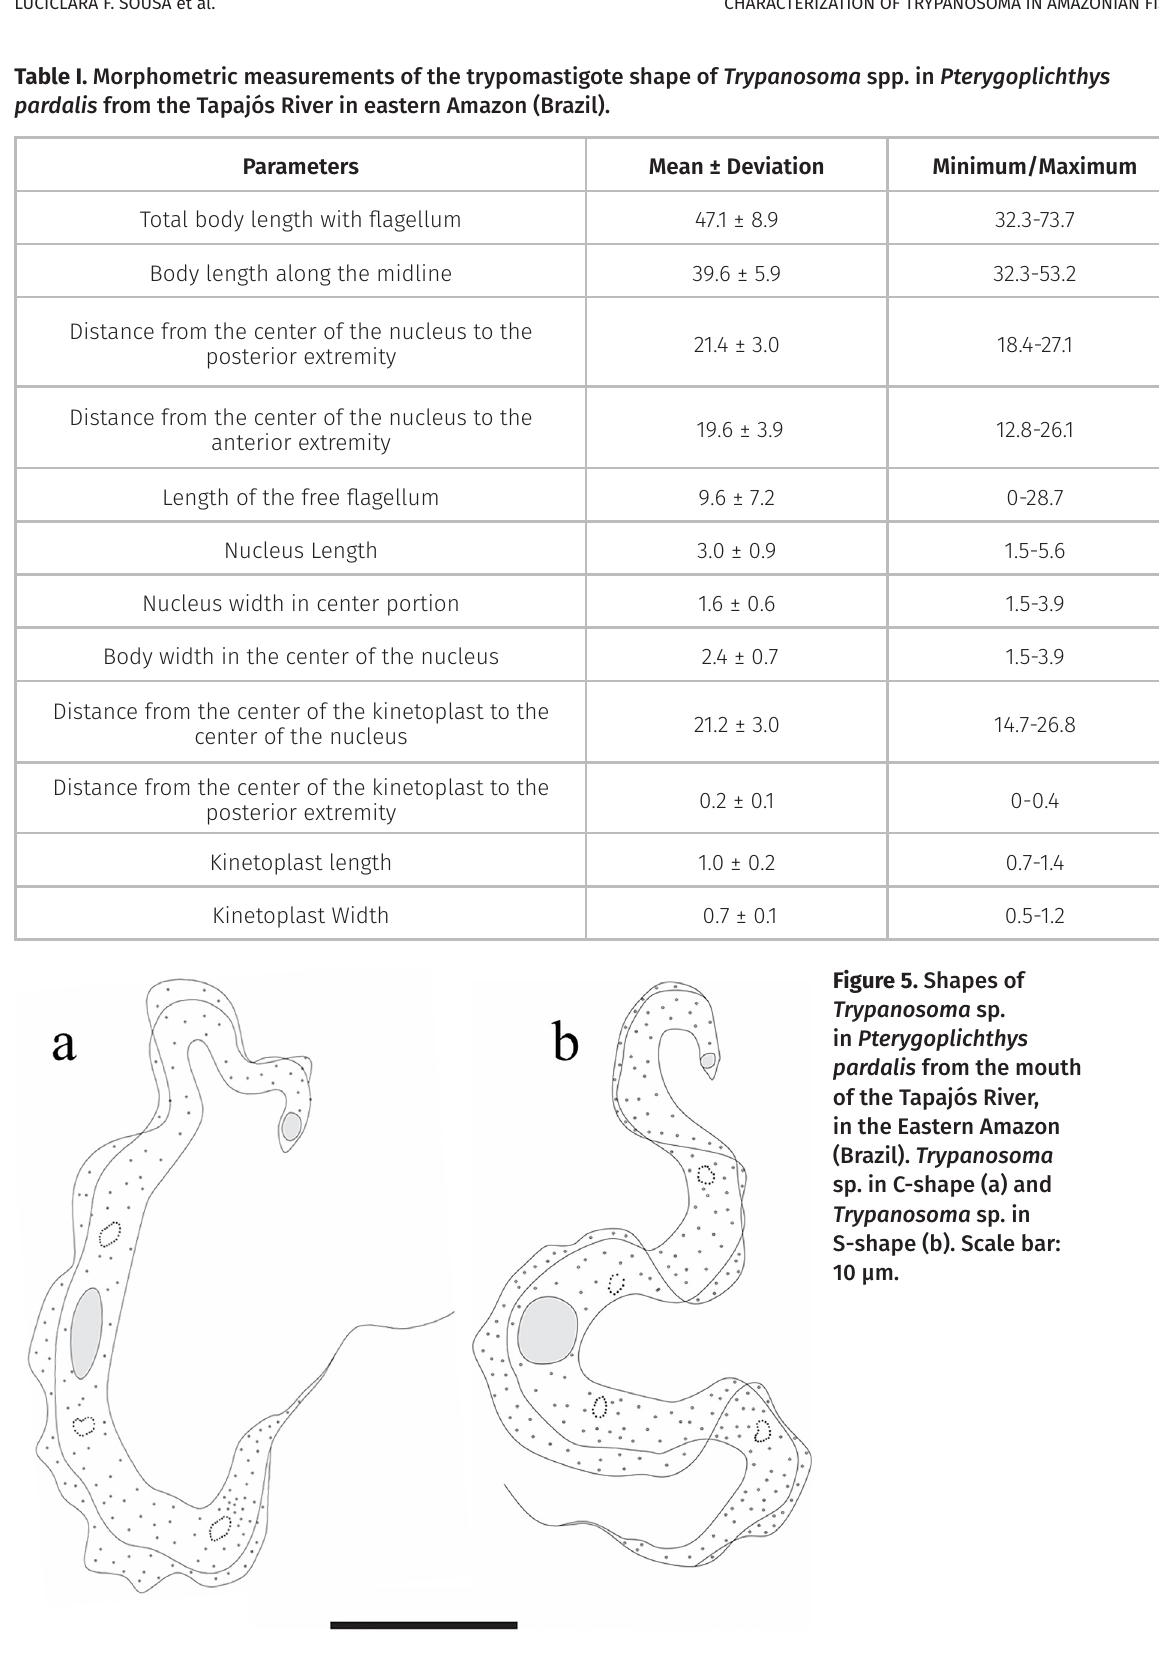
Table I. Morphometric measurements of the trypomastigote shape of Trypanosoma spp. in Pterygoplichthys pardalis from the Tapajós River in eastern Amazon (Brazil).